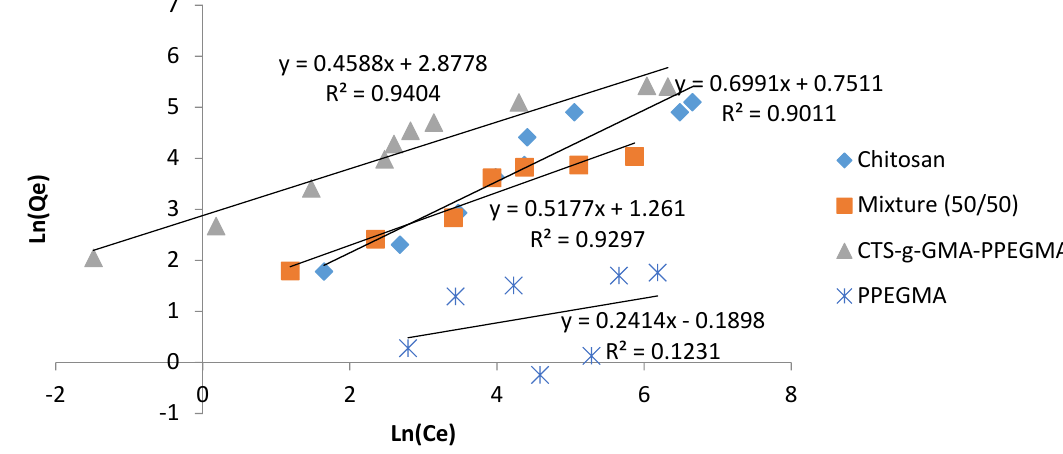
Figure 11. Linearized Freundlich isotherm.